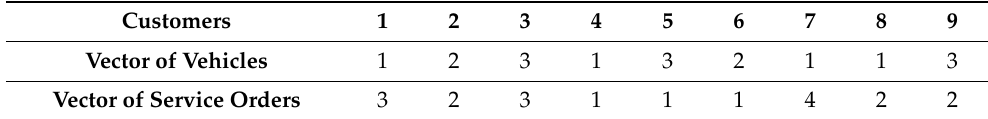
Table 3. Example of particle coding.